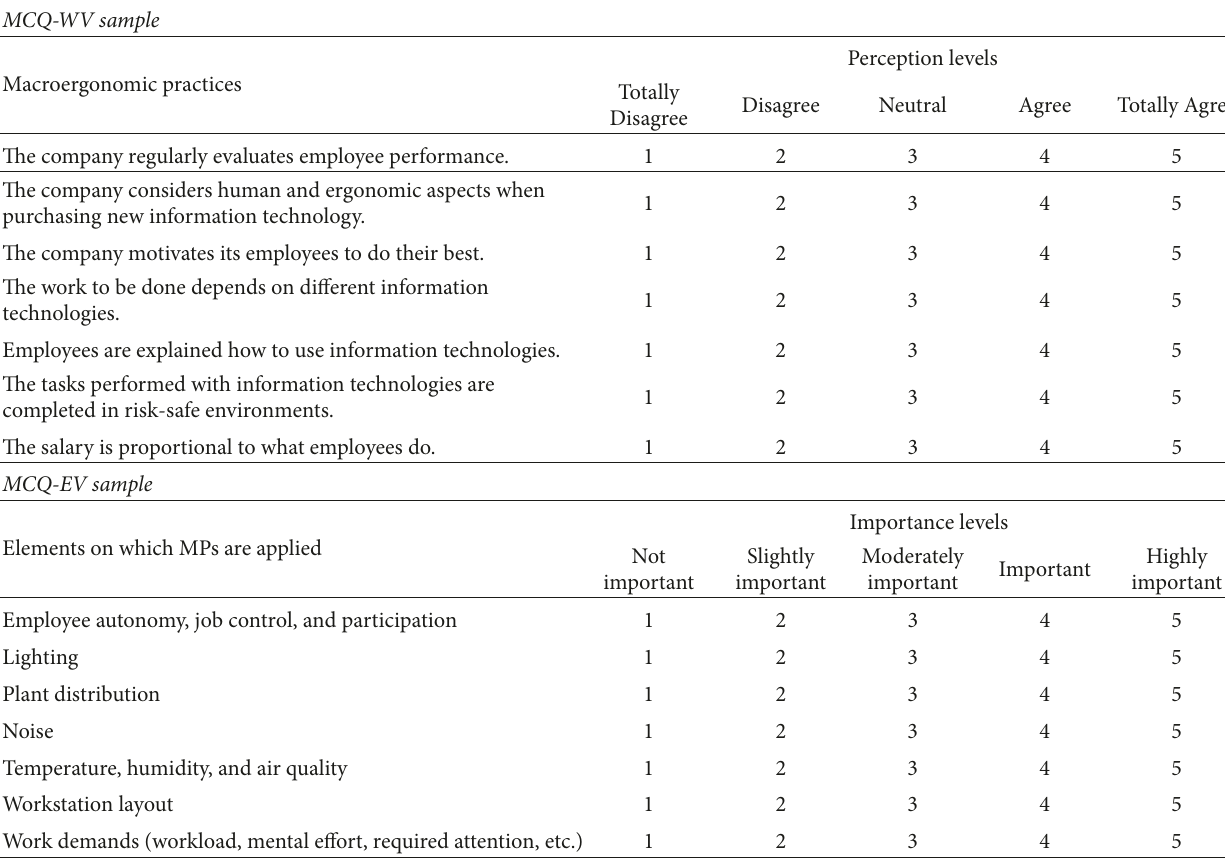
Table 1: Sample of the MCQ-WV and the MCQ-EV.